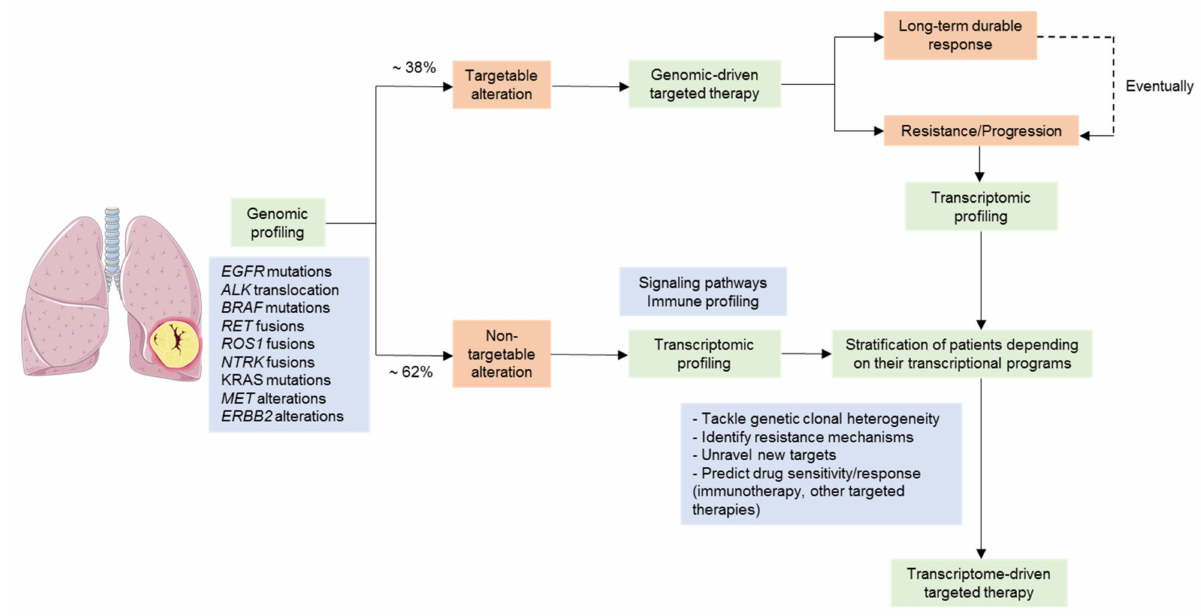
Figure 2. Transcriptional profiling as a tool for guiding precision medicine treatments in NSCLC. Flowchart representing key situations where gene expression profiling can add to genomic profiling in the management of NSCLC treatment. Molecular testing to detect targetable alterations is required in all non-squamous NSCLC to detect genomic alterations that cause an oncogenic addiction and for which there is an available targeted therapy (i.e., EGFR ). Although targeted therapies contributed to a significant improvement of the survival time in lung cancer patients harboring genomic alterations, patients will progress within several months due to the emergence of resistance mechanisms. More importantly, a significant proportion of patients do not harbor any actionable driver alteration. To incorporate new technologies, such as those centered on gene expression, might allow unraveling novel vulnerabilities other than genomic oncogenic